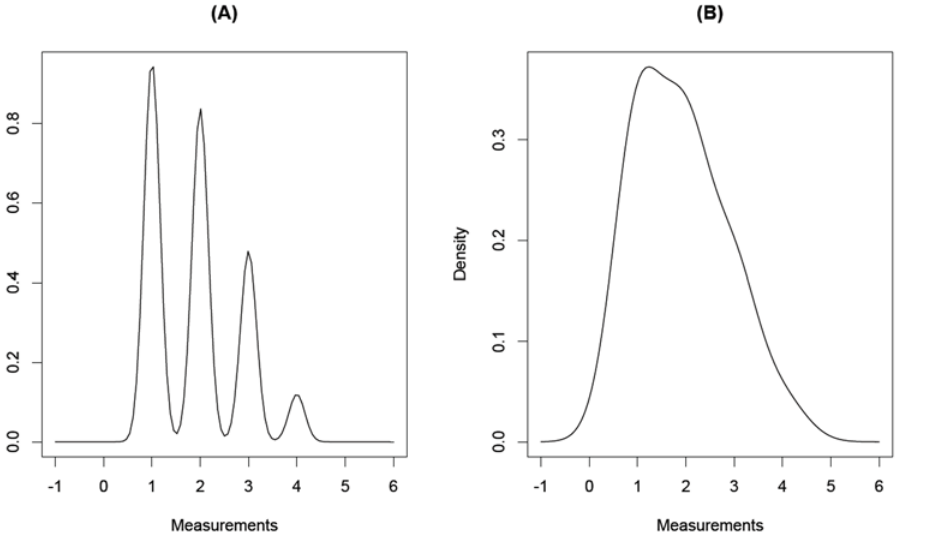
Figure 1. 1a and 1b. In this figures, we present probability density plots for statistical distributions that are mixtures of four univariate normal distributions with equally spaced means 1, 2, 3, and 4, and a common variance. In Figure 1a, the variance of each component distribution is 1 = 36 . In Figure 1b, the variance of each component distribution is J .